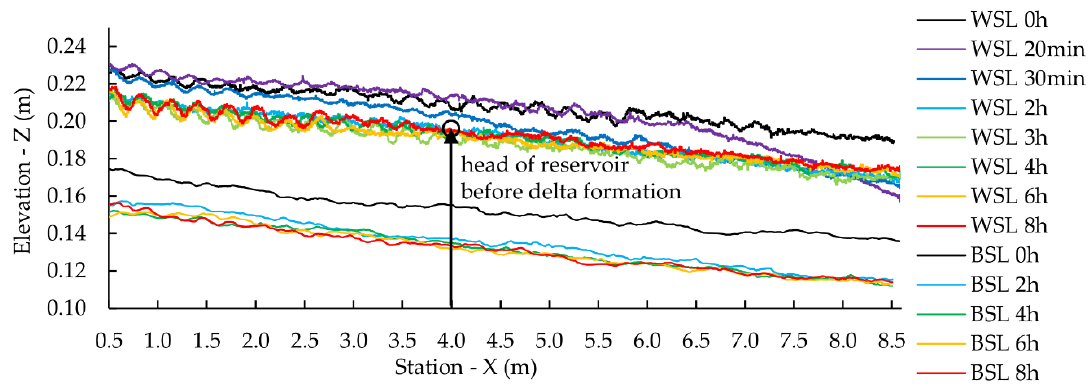
Figure 6. Bed and water surface profiles for test run E1 at the head of the reservoir at a flow rate of = water surface levels, BSL = bed surface levels. × HQ 0.7 × HQ 1 during flushing. WSL = water surface levels, BSL = bed surface levels. 0.7 1 during flushing. WSL